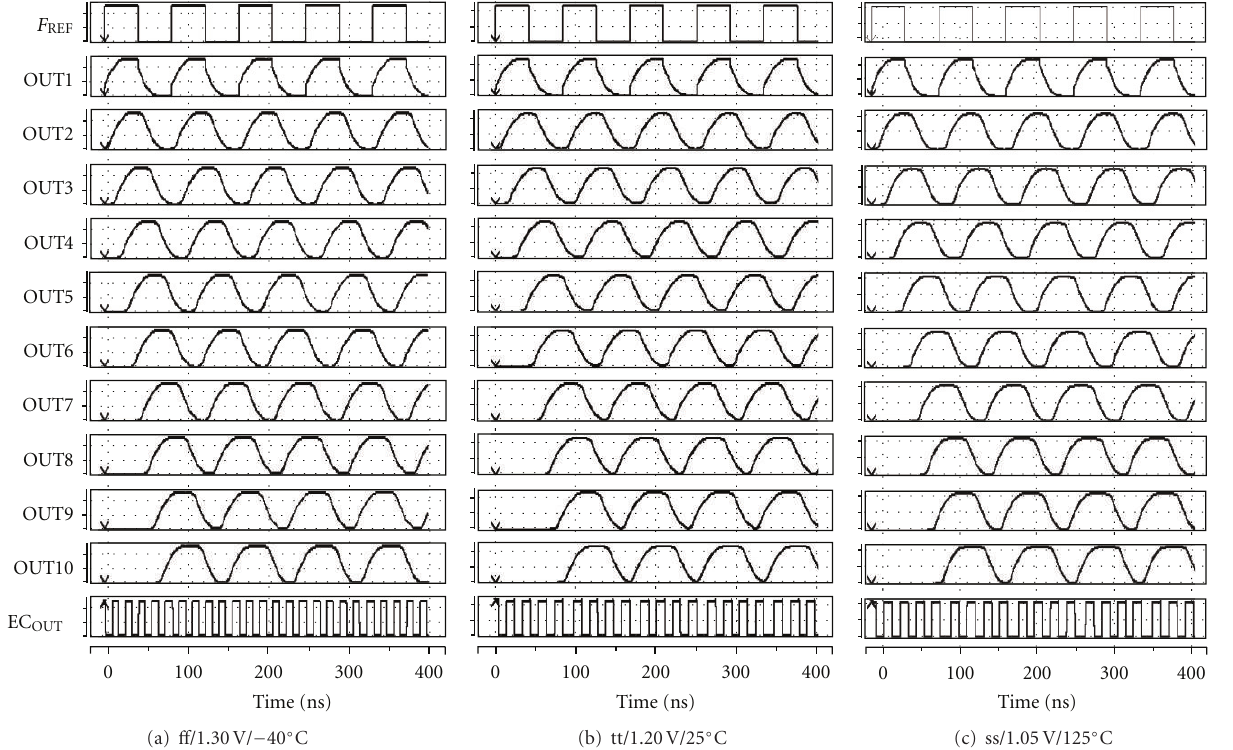
Figure 23: Postlayout simulation results from VCDL and EC applied to DLL1 for variable condition at V C = 0 . 5 V.